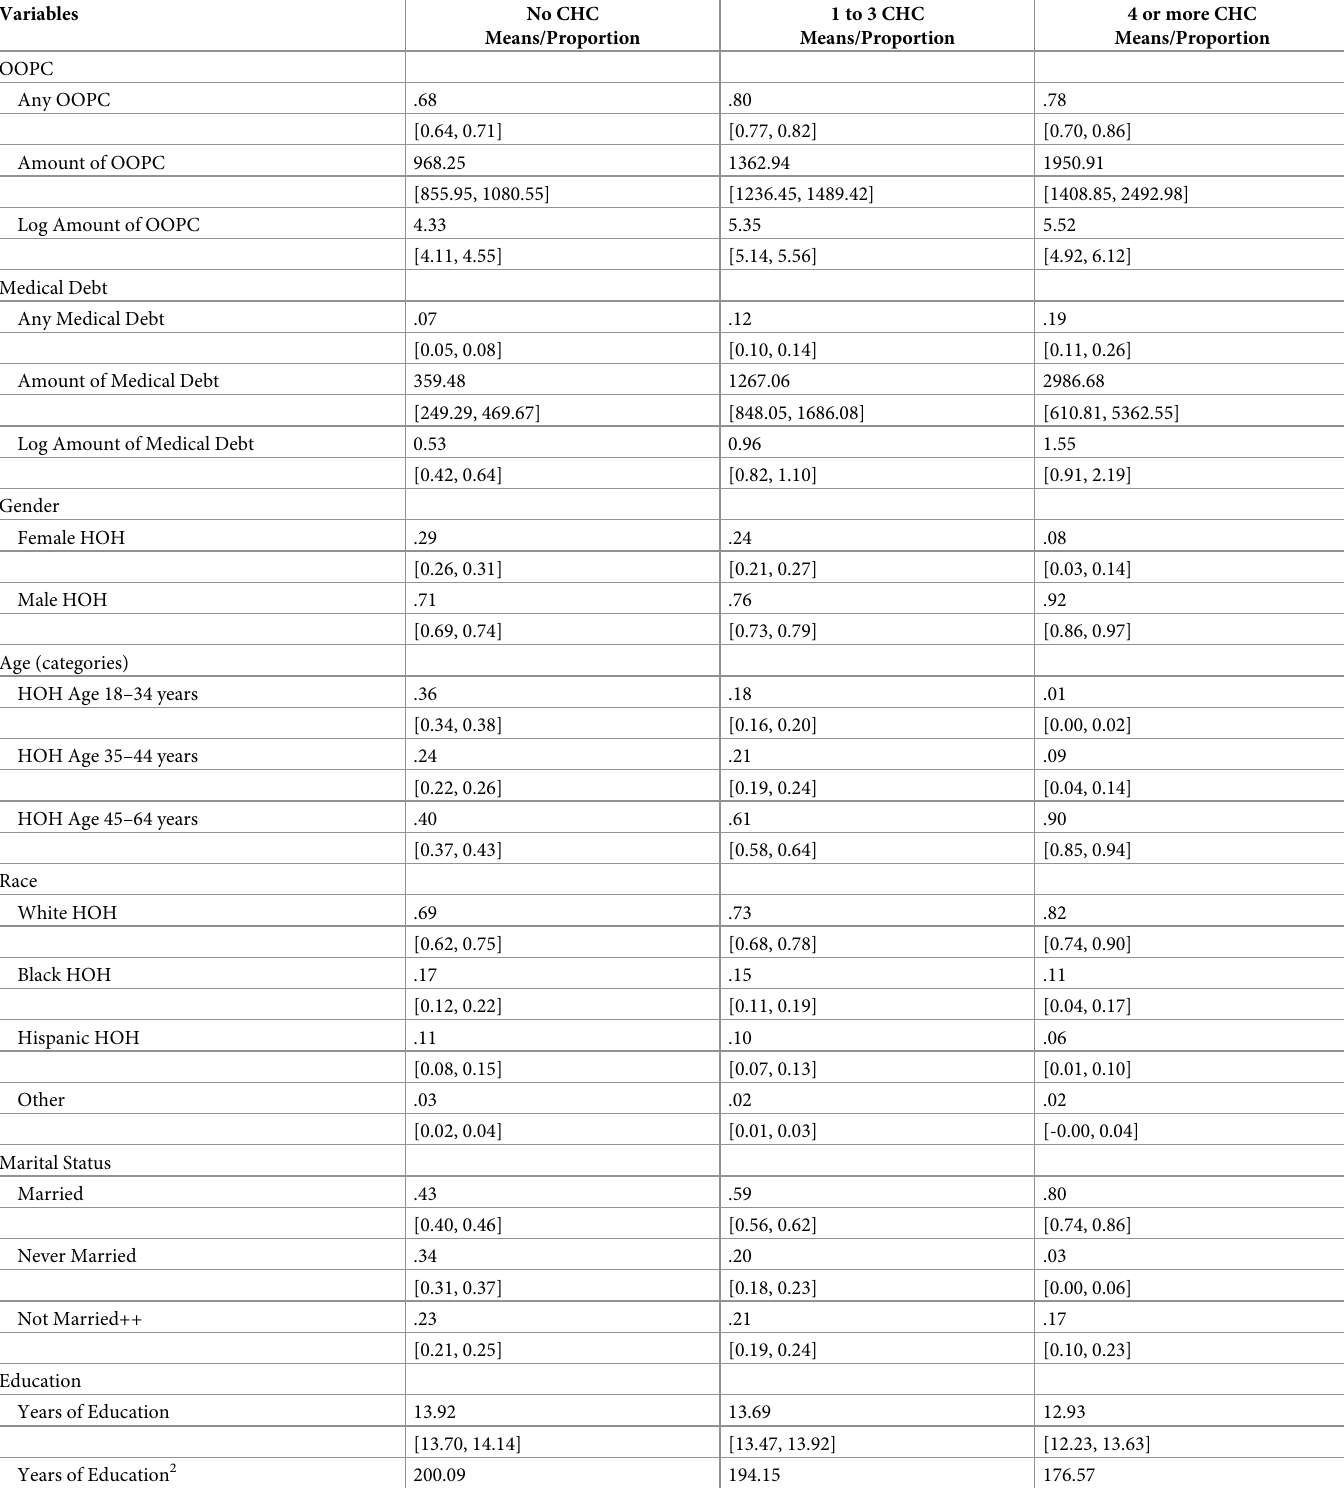
Table 1. Weighted summary statistics of dependent and independent variables ( N = 5,860), PSID